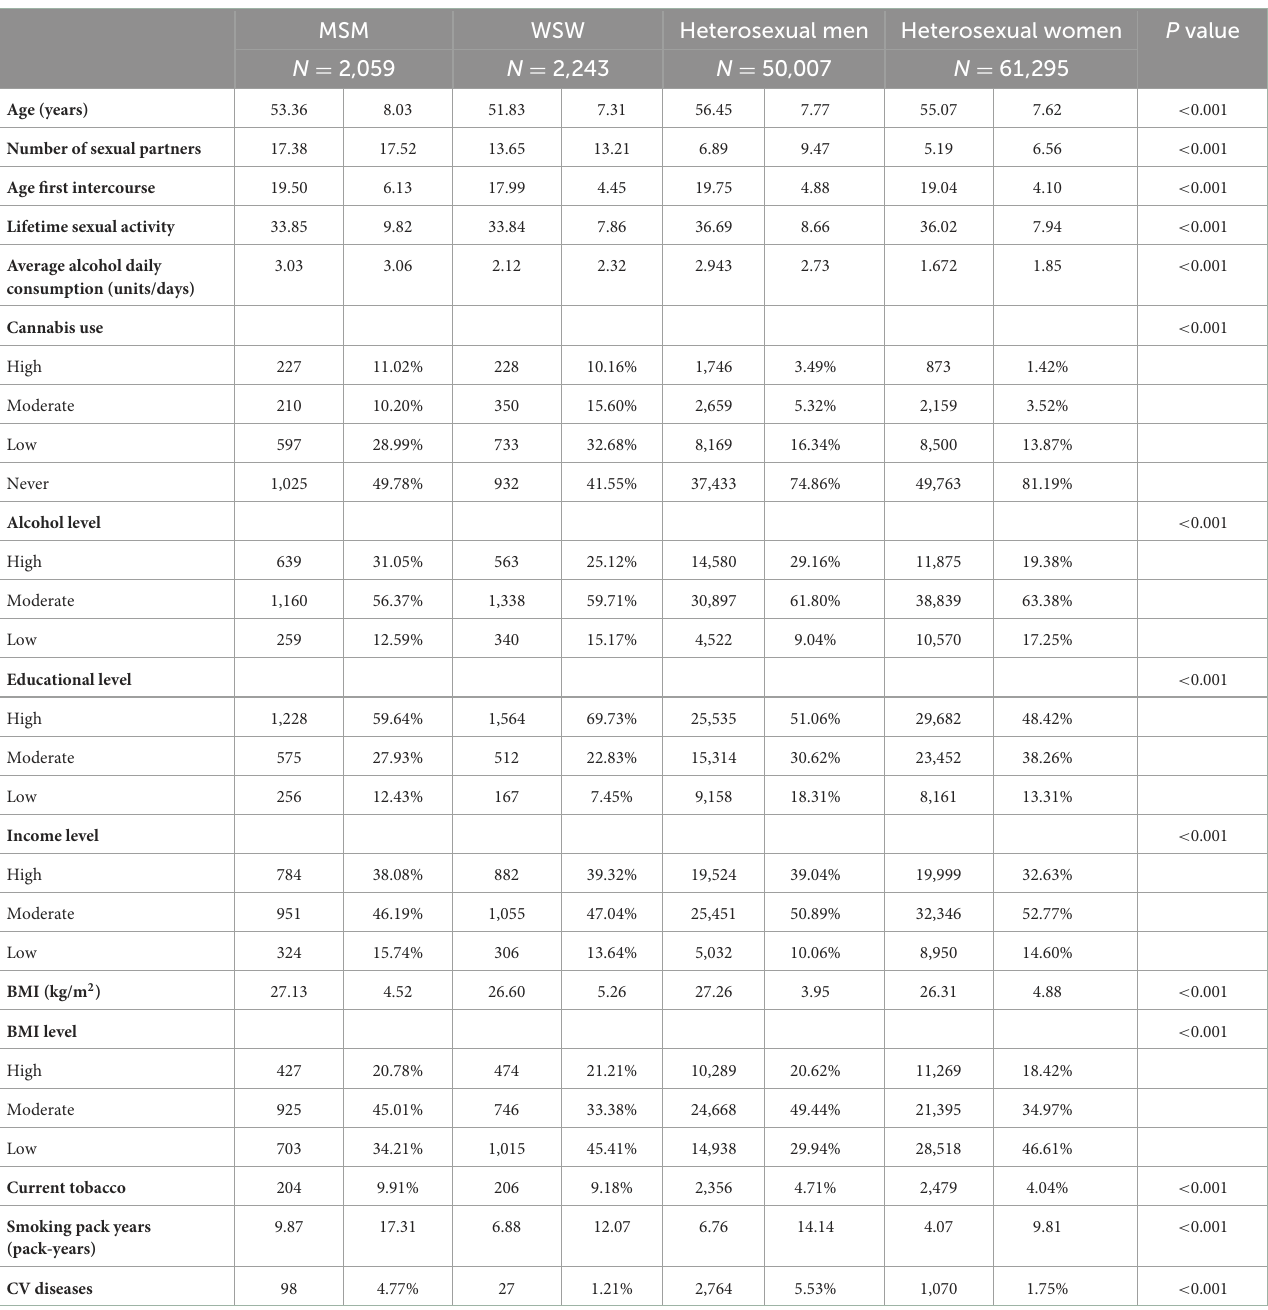
TABLE 1 Characteristics of the study population. MSM